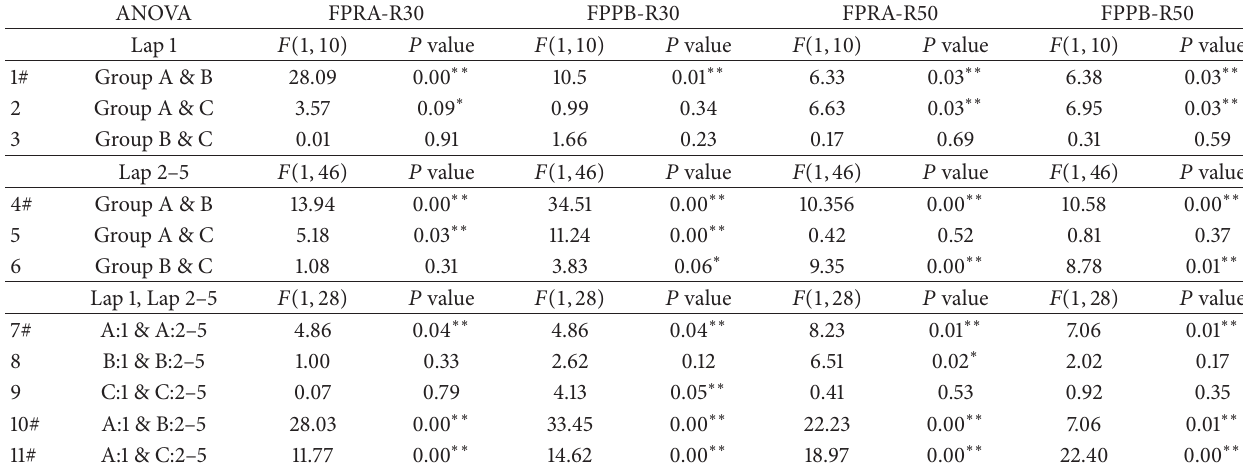
Table 3: The results of ANOVA analysis.